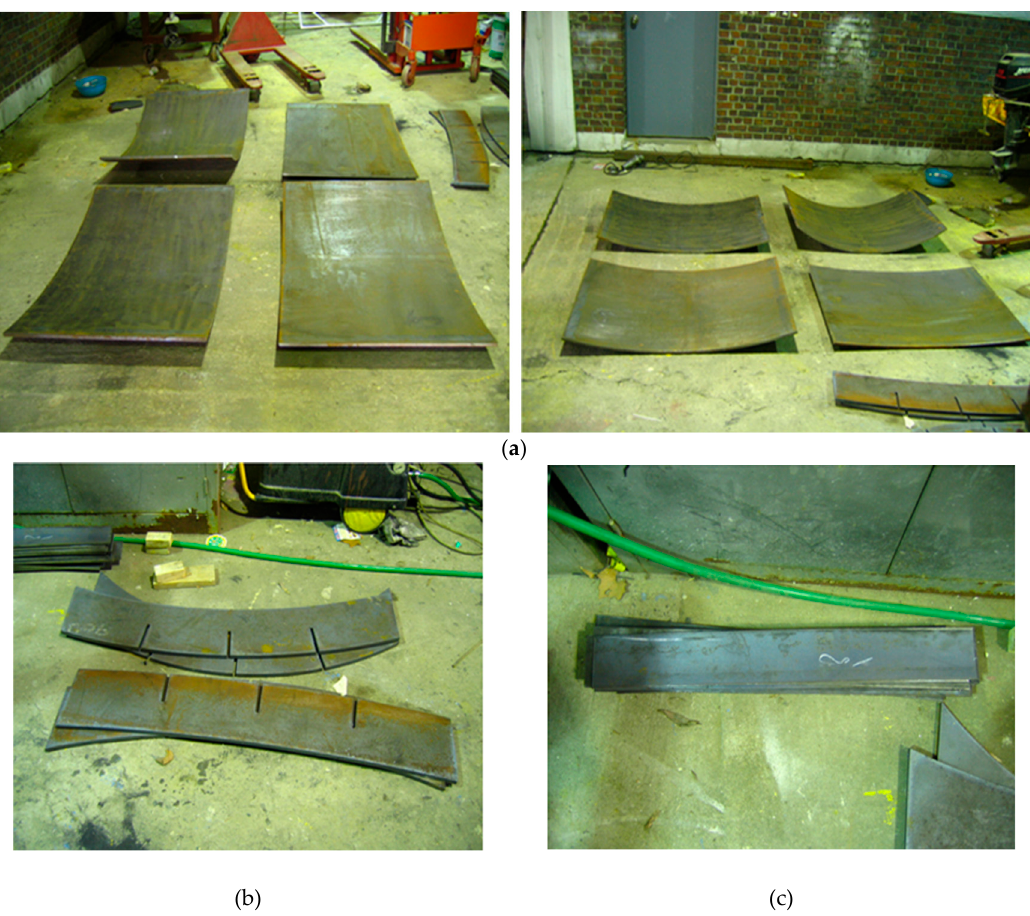
Figure 9. Plates and stiffeners for welding deformation: ( a ) base plates; ( b ) longitudinal stiffeners; ( c ) transverse stiffeners.